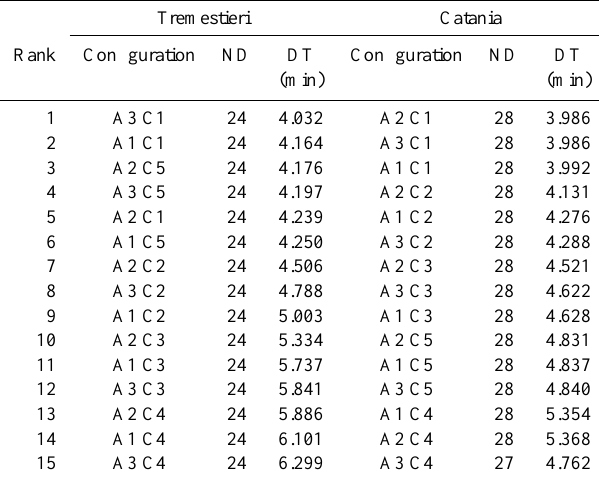
Table 3. Results of the event detections for the different configurations. Tremestieri Catania